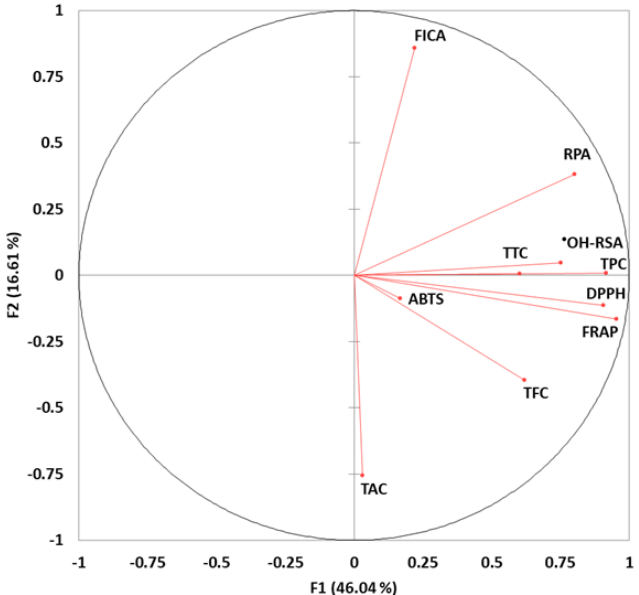
Figure 2. Principal component analysis (PCA) of the phenolic contents (TPC, TFC, TTC, phenolic acids, and flavonoids) and their antioxidant capacities (DPPH, FRAP, ABTS, RPA, • OH-RSA, FICA, and TAC) of banana cultivars.